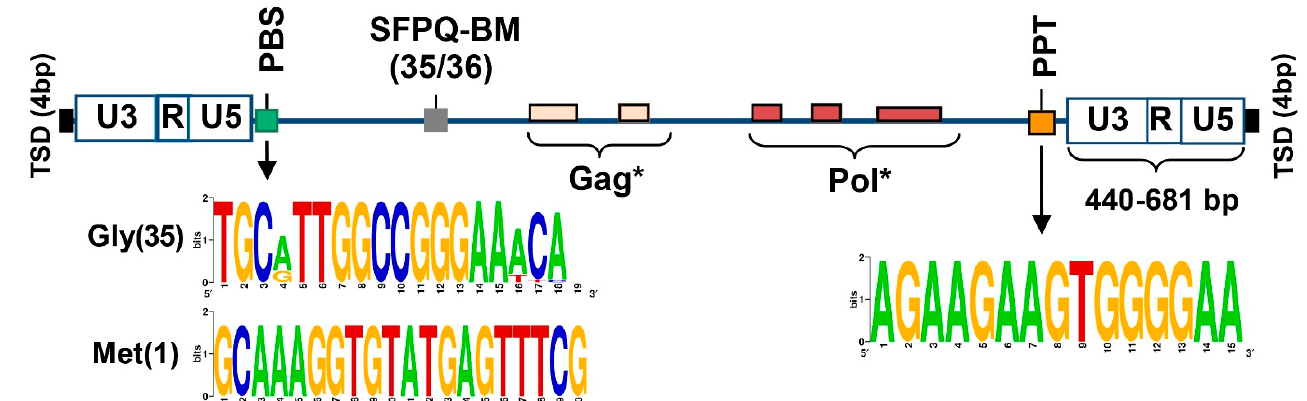
Figure 2. Structural properties of full-length SEV-VL30s. From left to right: TSD: Target site duplications, hallmark of integrations following Long Terminal Repeat (LTR) retrotransposition; U3-R-U5: structure of full-length LTRs (size of each LTR in base-pairs (bp) is depicted in 3 ′ LTR); PBS: Primer binding site, necessary for minus strand amplification during reverse transcription, including consensus sequences for the two types of tRNA species that are complementary for PBS; SFPQ-BM: Binding motifs for SFPQ protein; Gag and pol retroviral genes (* consensus sequences contain multiple stop codons and render VL30s non-autonomous retrotransposons); PPT: polypurine tract, necessary for puls strand amplification during reverse transcription.